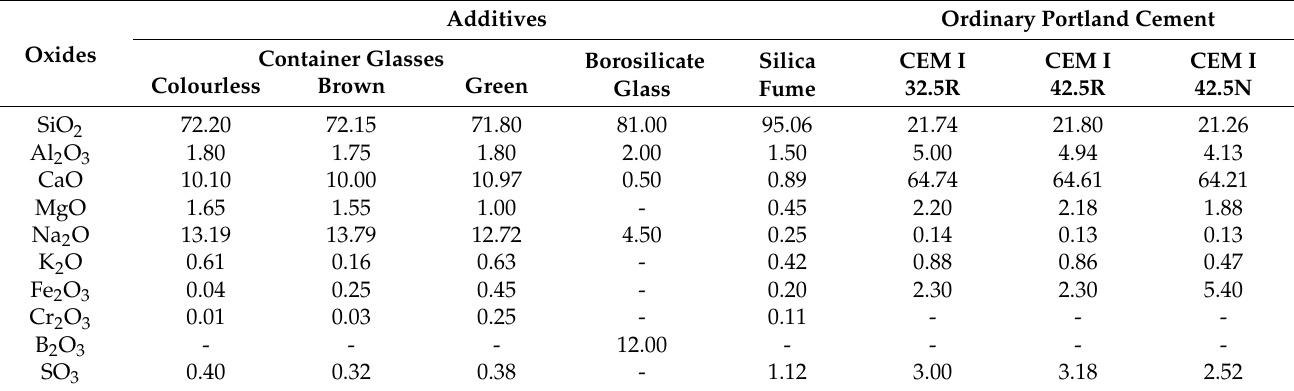
Table 1. Chemical composition of materials